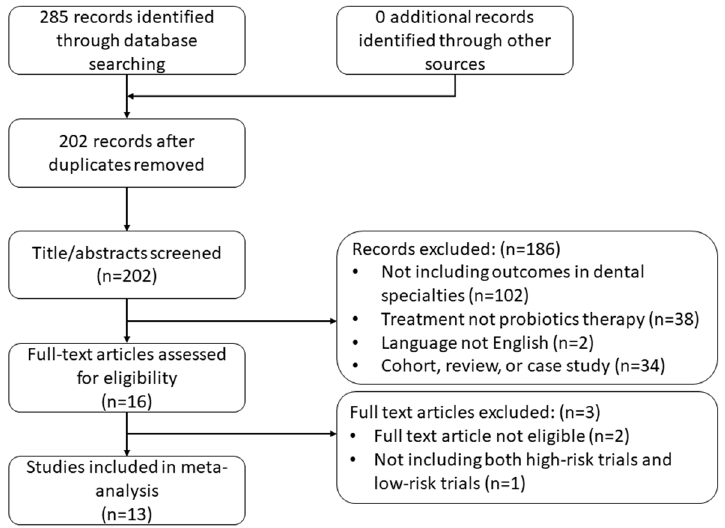
Figure 1. PRISMA flow diagram.